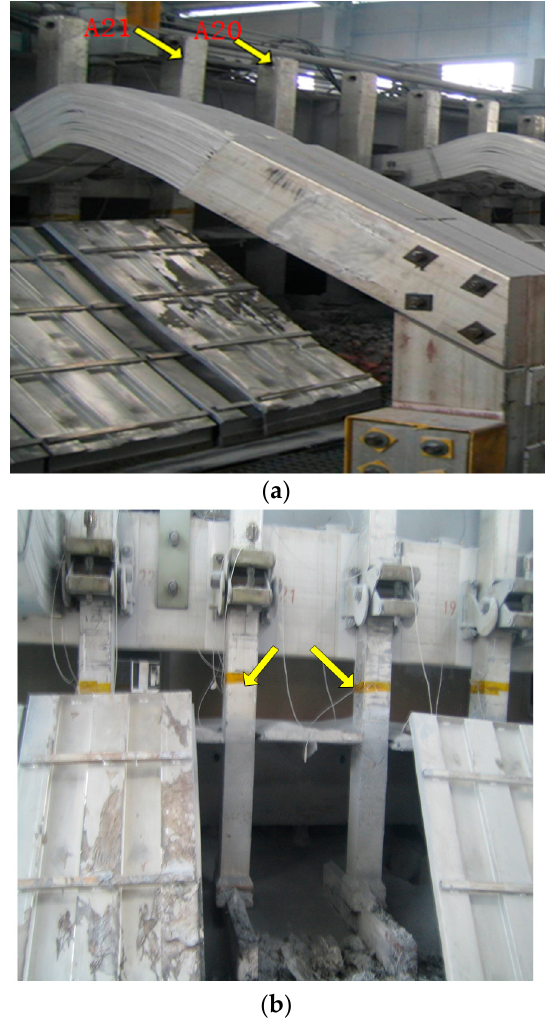
Figure 2. The experimental field. ( a ) The anode guide rod; ( b ) the point used to measure the voltage.